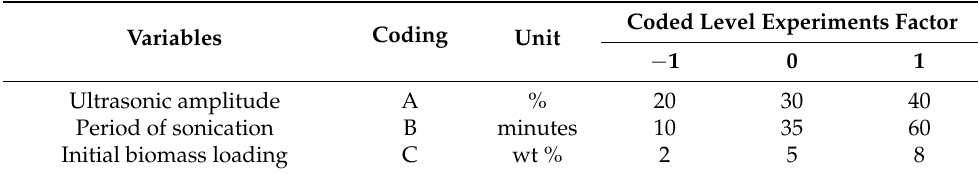
Table 1. Experimental design for response surface methodology (RSM). Variables Coding